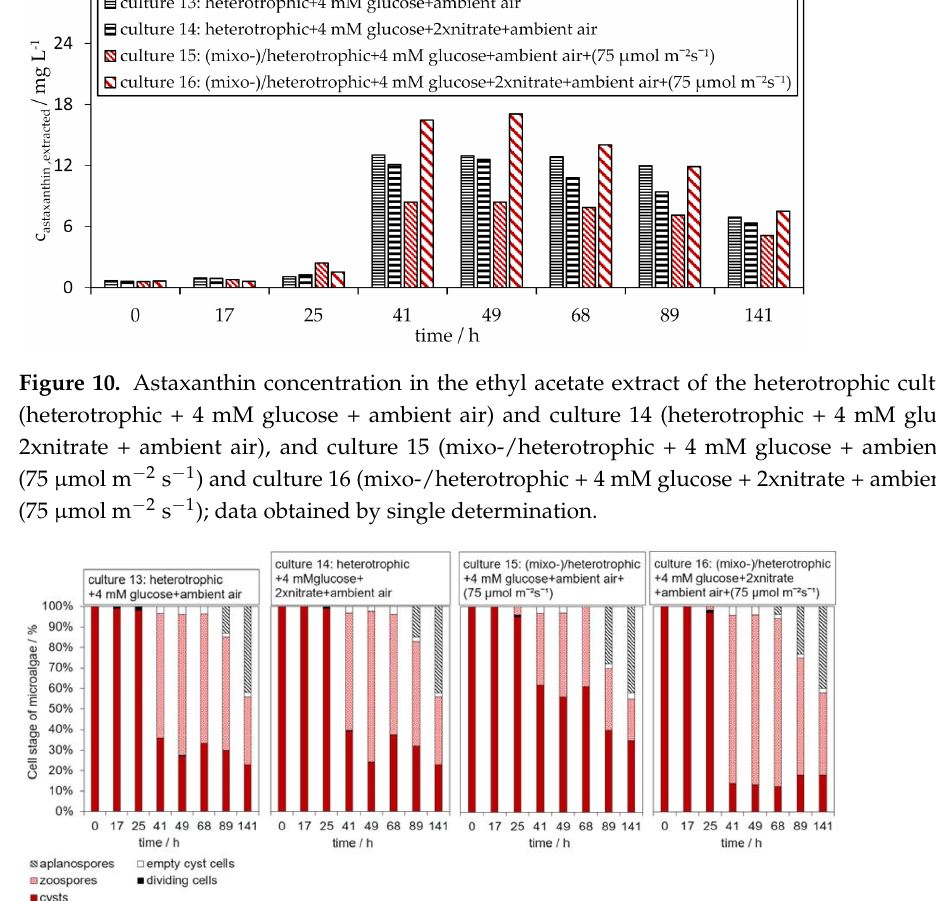
Figure 11. Relative distribution of the cell stages of H. pluvialis at different times after the start of germination for the heterotrophic culture 13 (heterotrophic + 4 mM glucose + ambient air) and culture 14 (heterotrophic + 4 mM glucose + 2xnitrate + ambient air), and culture 15 (mixo-/heterotrophic + 4 mM glucose + ambient air + (75 µ mol m − 2 s − 1 ) and culture 16 (mixo-/heterotrophic + 4 mM glucose + 2xnitrate + ambient air + (75 µ mol m − 2 s − 1 ); data obtained by single